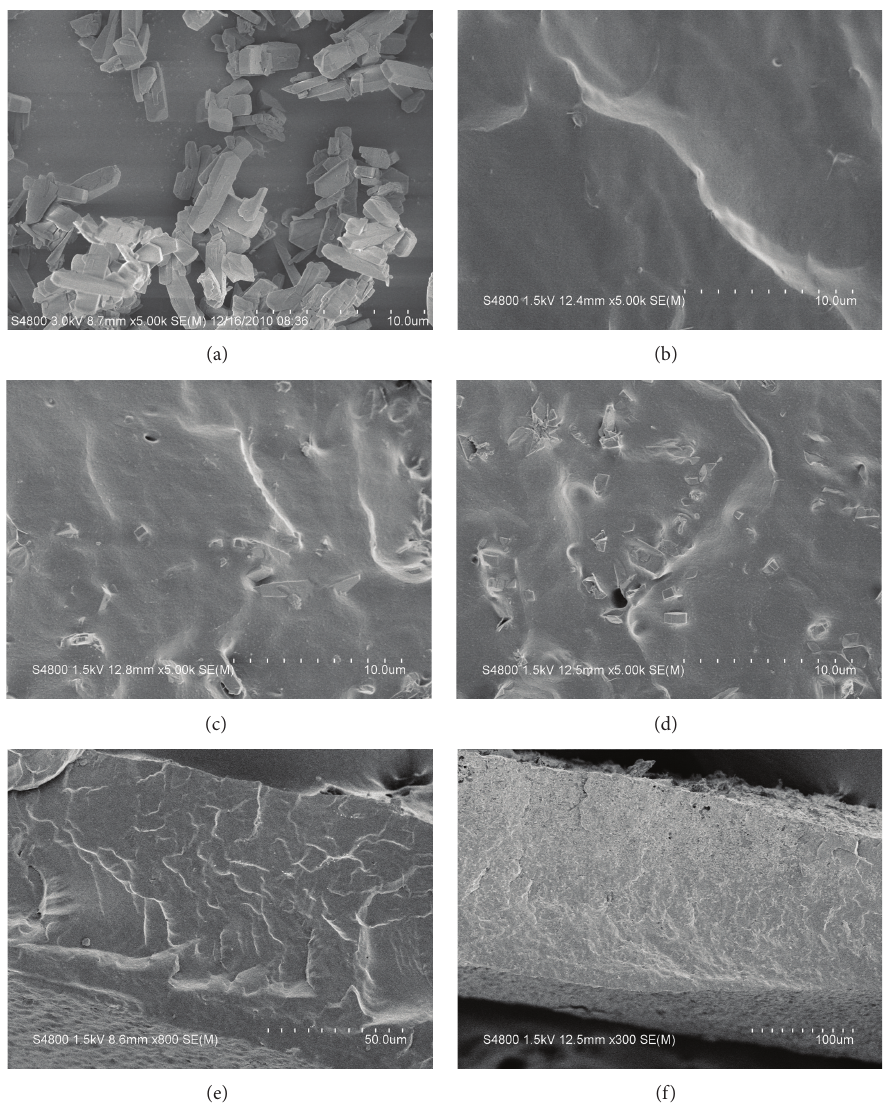
Figure 3: SEM images of ZSM-5 particles and the cross-section of membranes, (a) ZSM-5 particles, (b) pure PEBA, (c) PEBA/ZSM-5-10 (d) PEBA/ZSM-5-40, and (e) and (f) are the whole cross-sectional images of PEBA and PEBA/ZSM-5-40 membrane,